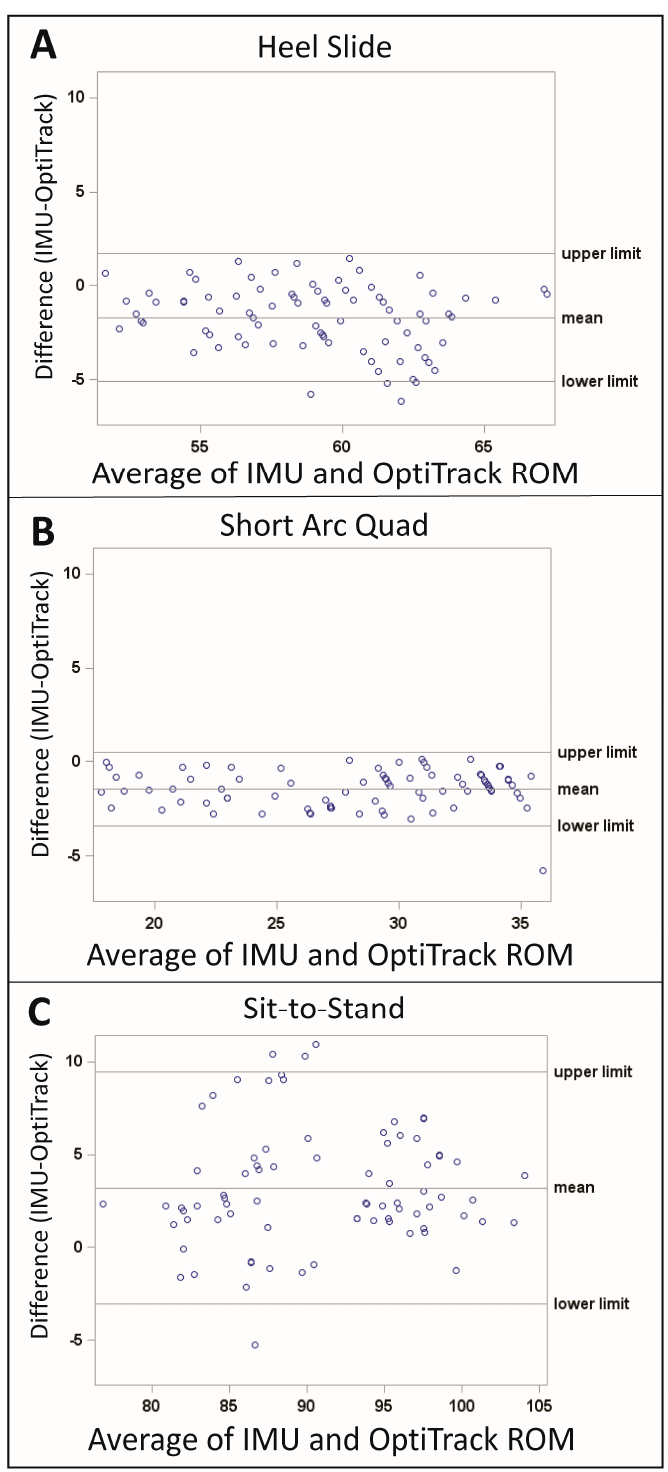
Figure 2. Bland-Altman Plots displaying the differences between the IMU and OptiTrack for the ( A ) heel slide, ( B ) SAQ, and ( C ) sit-to-stand exercises.